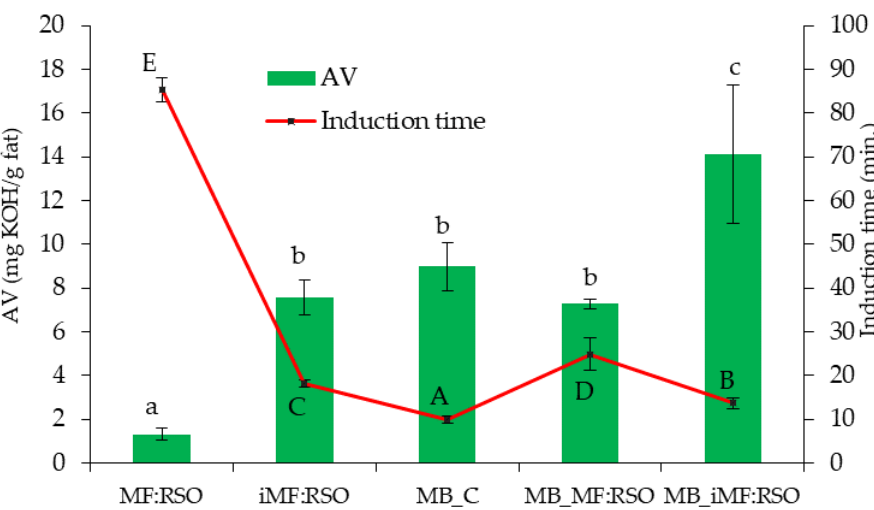
Figure 3. Acid value (AV) and induction time of fats used in model meat batters and extracted from model meat batters. Different letters indicate that the samples are considered significantly different at the 5% level ( p < 0.05). MF:RSO—noninteresterified mixture of milkfat and rapeseed oil, iMF:RSO—interesterified mixture of milkfat and rapeseed oil, MB_C—control meat batters with pork jowl, MB_MF:RSO—meat batters produced with a noninteresterified mixture of milkfat